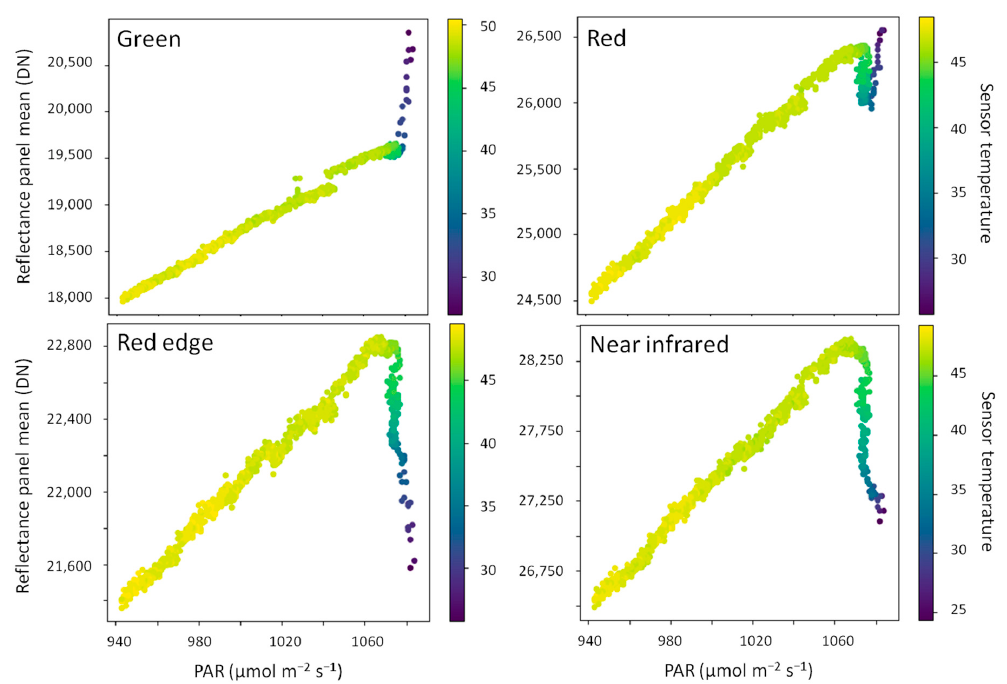
Figure 10. Relationship between exposure-calibrated and vignetting-corrected digital number (DN) values and irradiance (PAR). For lower camera temperatures, the relationship was strongly nonlinear; however, once the camera warmed up, the relationship became linear.